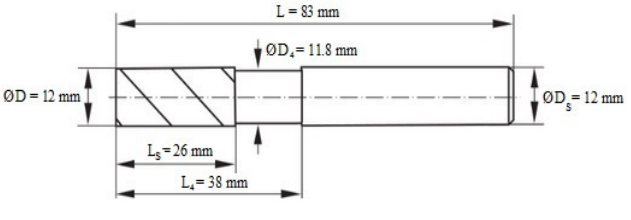
Figure 2. Shape and dimensions of tool [26].